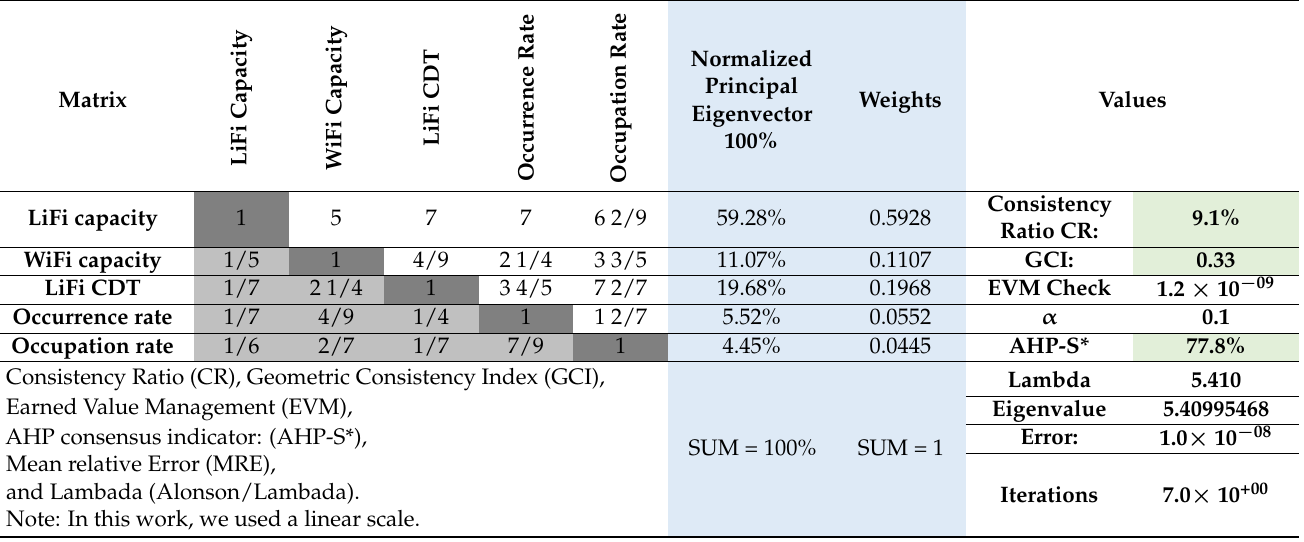
Table 19. AHP weight